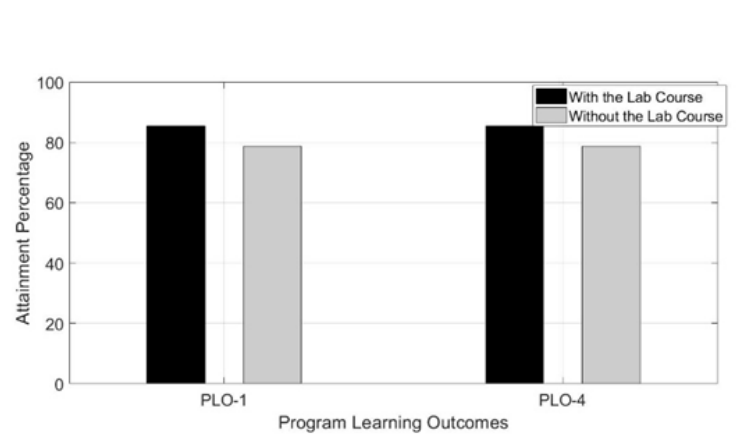
Figure 8. Percentage PLO attainment for the lab course